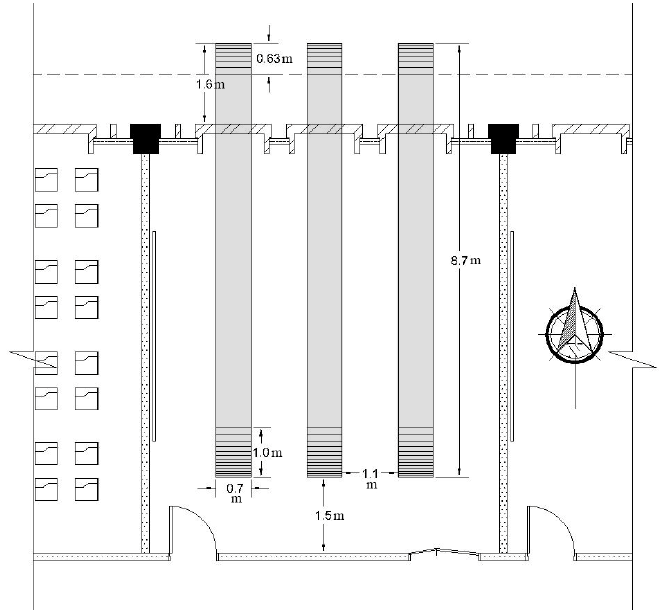
Figure 9. Ceiling plan of a typical classroom showing the suggested northern anidolic ducts.